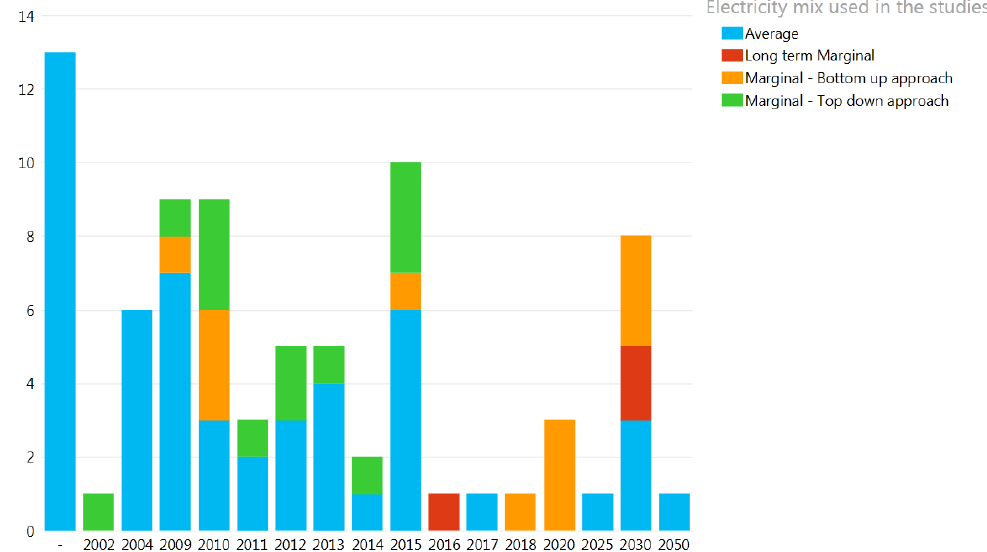
Figure 5. Number of analyses sorted by time horizon. Some studies do not make explicit the time horizon of their study. In this case the year of the electricity dataset used in the analysis has been considered, if available; otherwise they are accounted in the first column. Note that each study can have more than one time-horizon in its analysis.